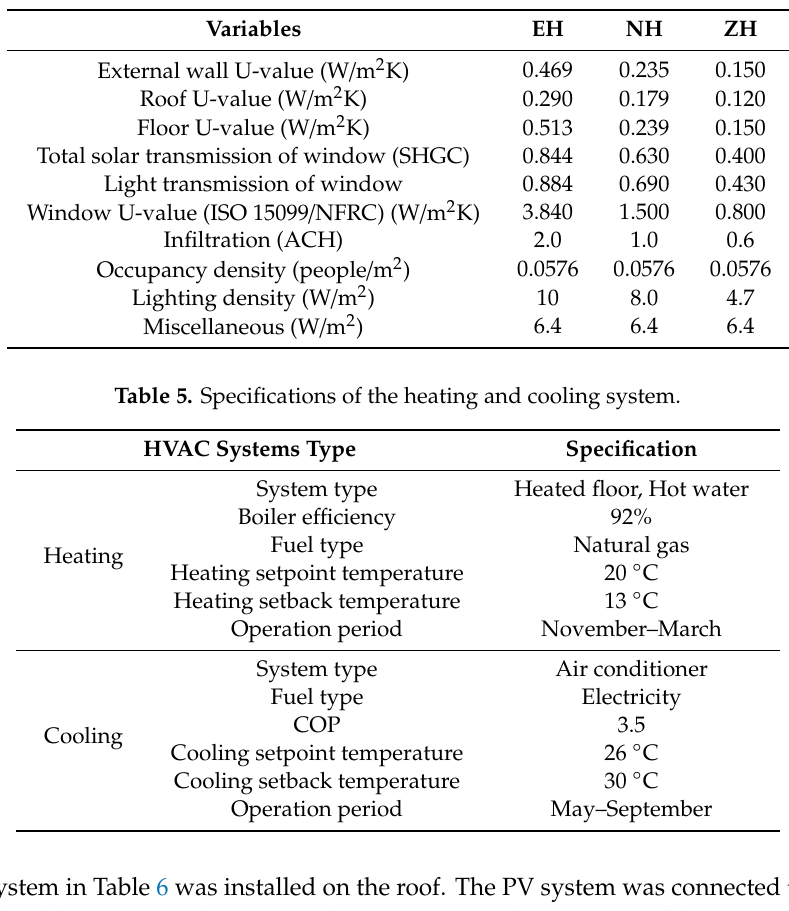
Table 4. Input variables by building types.